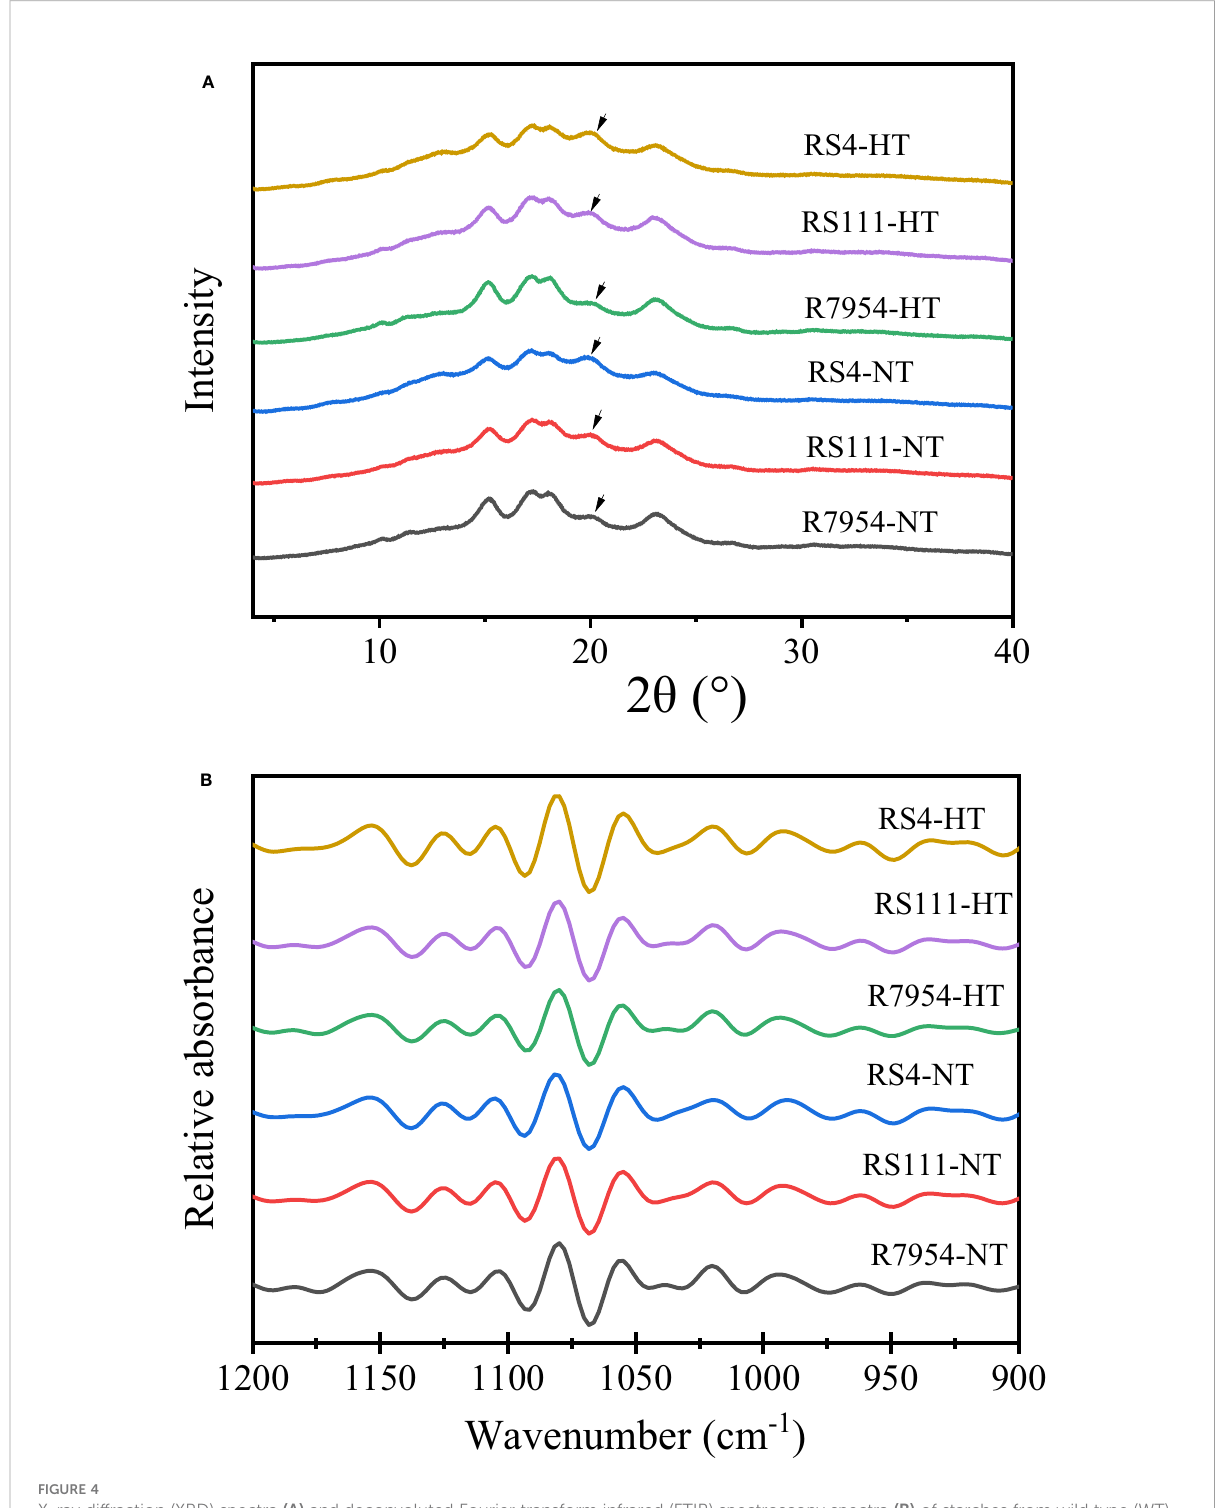
FIGURE 4 X-ray diffraction (XRD) spectra (A) and deconvoluted Fourier transform infrared (FTIR) spectroscopy spectra (B) of starches from wild type (WT) and mutants at normal temperature (NT) and high temperature (HT). The arrow in panel (A) indicated the peaks of starch – lipid